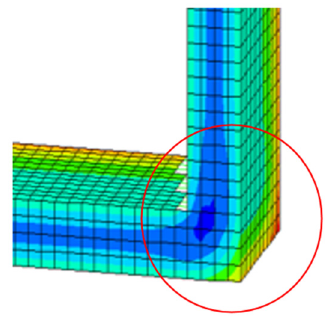
Figure 11. Precast model indicating the cracking region.